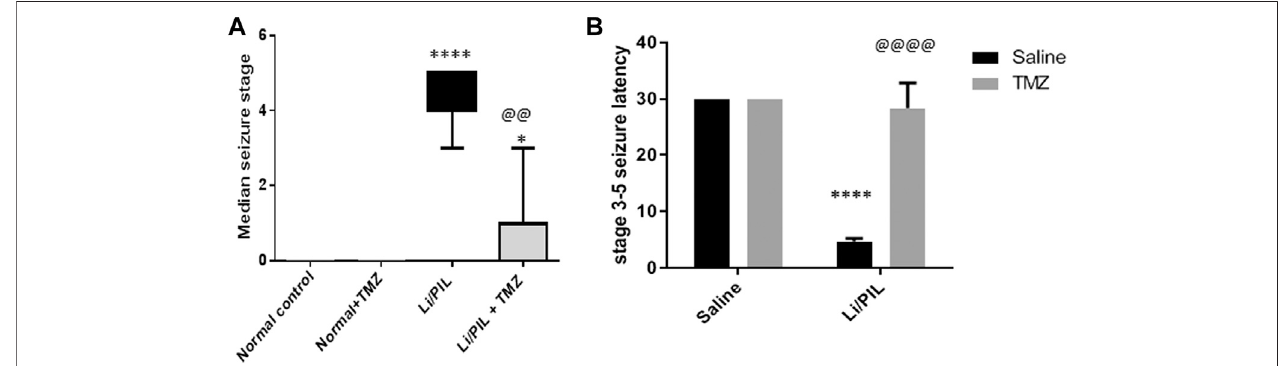
FIGURE1| EffectofTMZ onLi/PIL-induced seizures. (A) Racine score, dataare expressed asbox plots ofthemedian of15animals.Statisticalanalysiswasdone using the Kruskal – Wallis test followed by Dunn ’ s test. (B) Seizure latency, data are expressed as mean of 15 animals ± SD. Two-way ANOVA followed by the Tukey – Kramerpost-hoctestwasusedforstatisticalanalyses.*Signi fi cantlydifferentfromthenormalcontrolgroup (Saline)at p < 0.05;****Signi fi cantlydifferentfromthe normal control group (Saline) at p < 0.0001; @@ Signi fi cantly different from the Li/PIL control group at p < 0.01; @@@@ Signi fi cantly different from the Li/PIL control group at p <